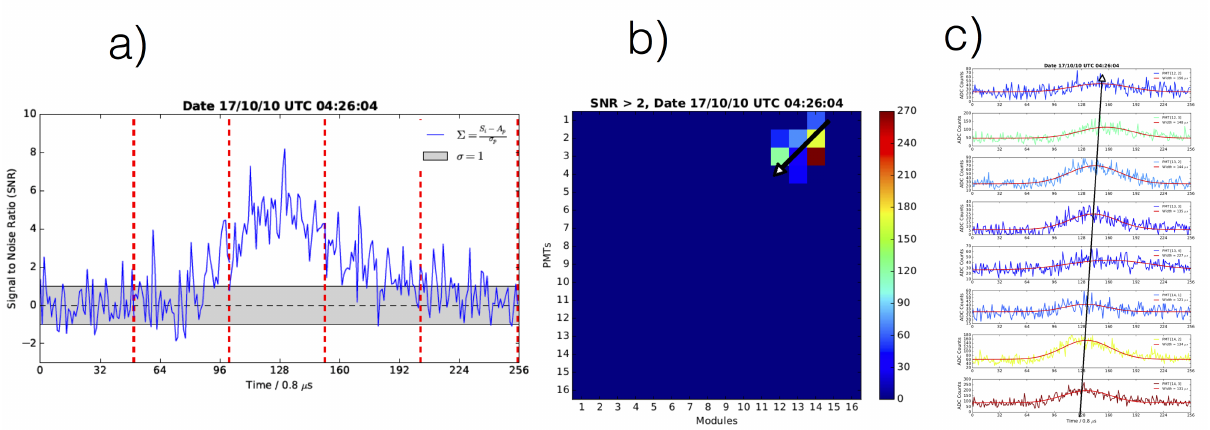
Figure 2. Data analysis of TUS event TUS171010: a) Signal selection on a pixel by requiring SNR > 2; b) track of the pixels satisfying condition a); c) time profile of the signal in the pixels indicated in b). A gaussian fit is performed on the data to have a better description of the time evolution of the signal maximum in each pixel.